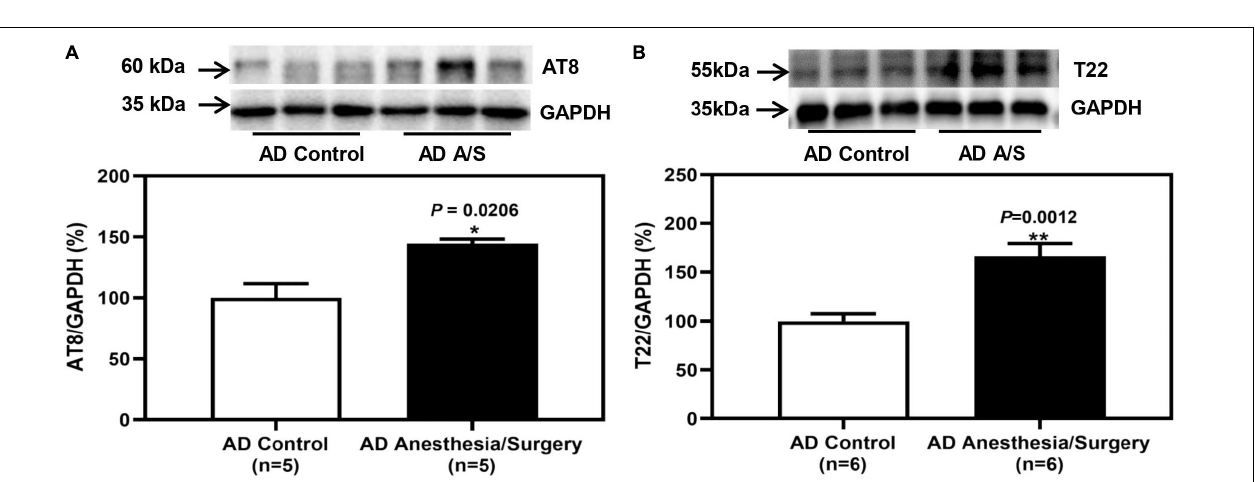
FIGURE 3 | The effect of anesthesia and surgery on the cognition of LM mice and 5XFAD Tg mice. The percent freezing of LM mice and 5XFAD Tg mice in control and anesthesia/surgery group on day 3 after anesthesia and surgery in context (A) and tone (B) FCT. The percent freezing of LM mice and 5XFAD Tg mice in control and anesthesia/surgery group on day 7 after anesthesia and surgery in context (C) and tone (D) FCT. The FCT revealed that LM mice showed no cognitive dysfunction both on day 3 and day 7 after anesthesia and surgery, but 5XFAD Tg mice showed a cognitive decline in context, but not tone test, on day 3 after anesthesia and surgery. 5XFAD Tg mice showed no cognitive impairment in both context and tone test on day 7 after anesthesia and surgery. Results are expressed as mean ± SEM, n = 12. Student t -test. * P < 0.05 vs. untreated controls. N.S., P > 0.05 vs. untreated controls.